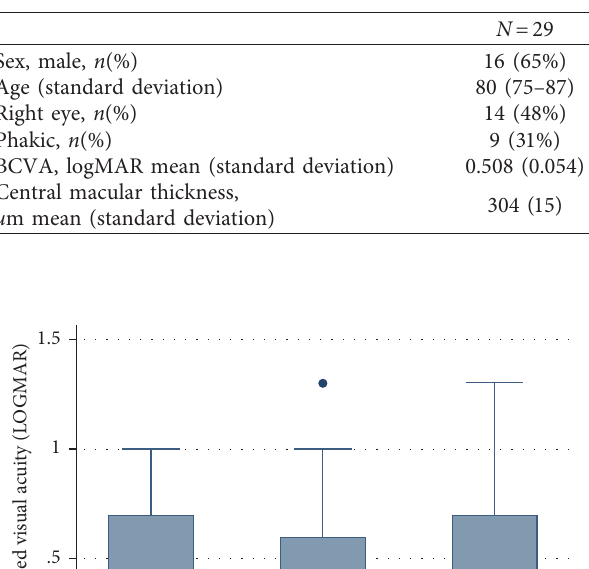
Table 1: Baseline demographics and clinical